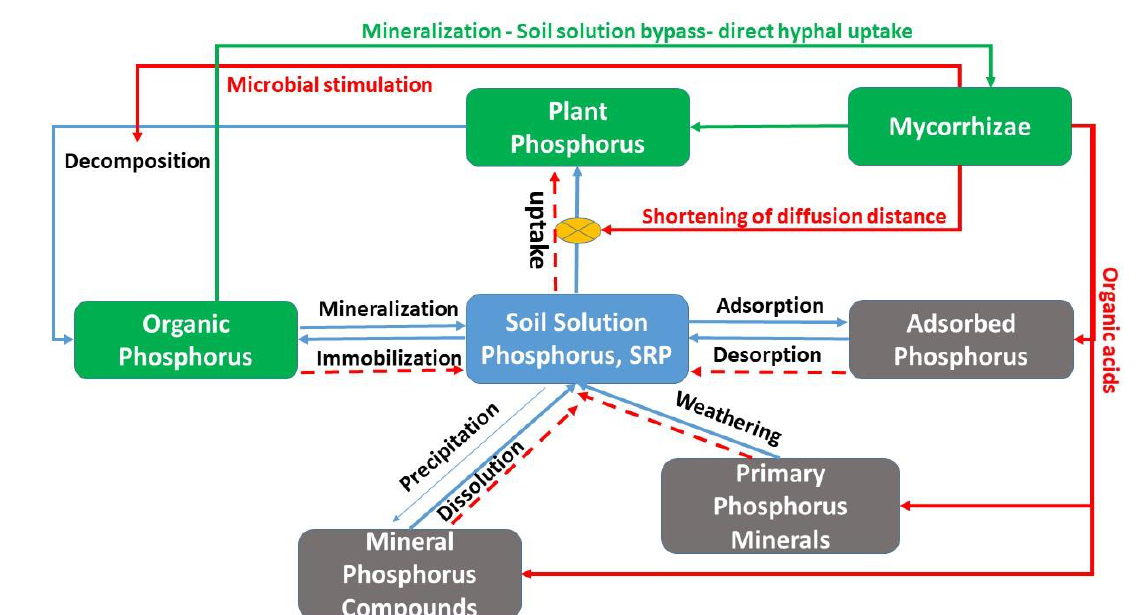
Figure 1. Influence of mycorrhizae on phosphorus cycling processes and pools. Red and green arrows are processes influenced by mycorrhizae. Broken lines show the net direction of reactions due to mycorrhizal effects.